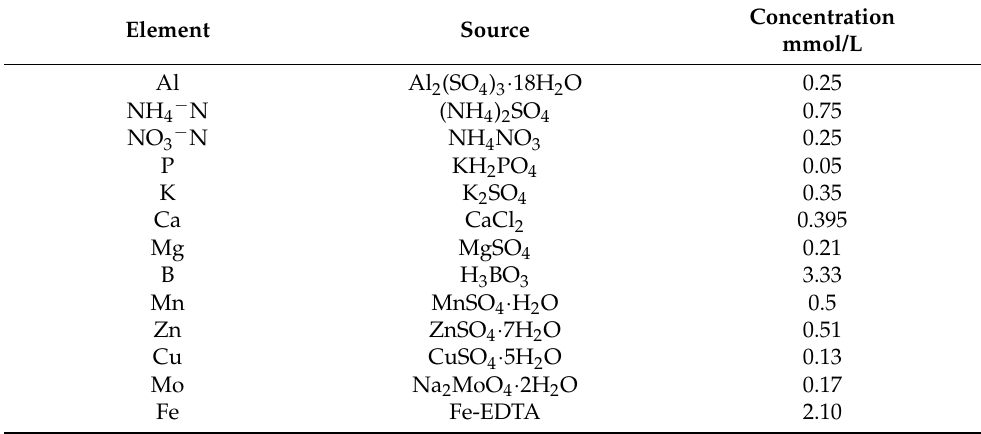
Figure 6. Experimental setup of tea seedlings in varying nutrient solutions for culture used in this study. Table 1. Composition of the hydroponic solution used for the culture of tea seedlings.